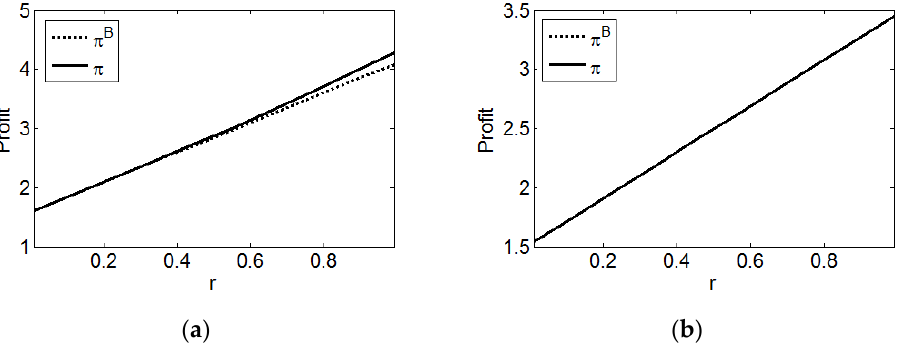
β β+ . ( a ) r Figure 8. Impacts of r on the brand’s profit with different β o + β s . ( a ) β o = β s = 0.4; ( b ) β o = β s = 0.6. o s